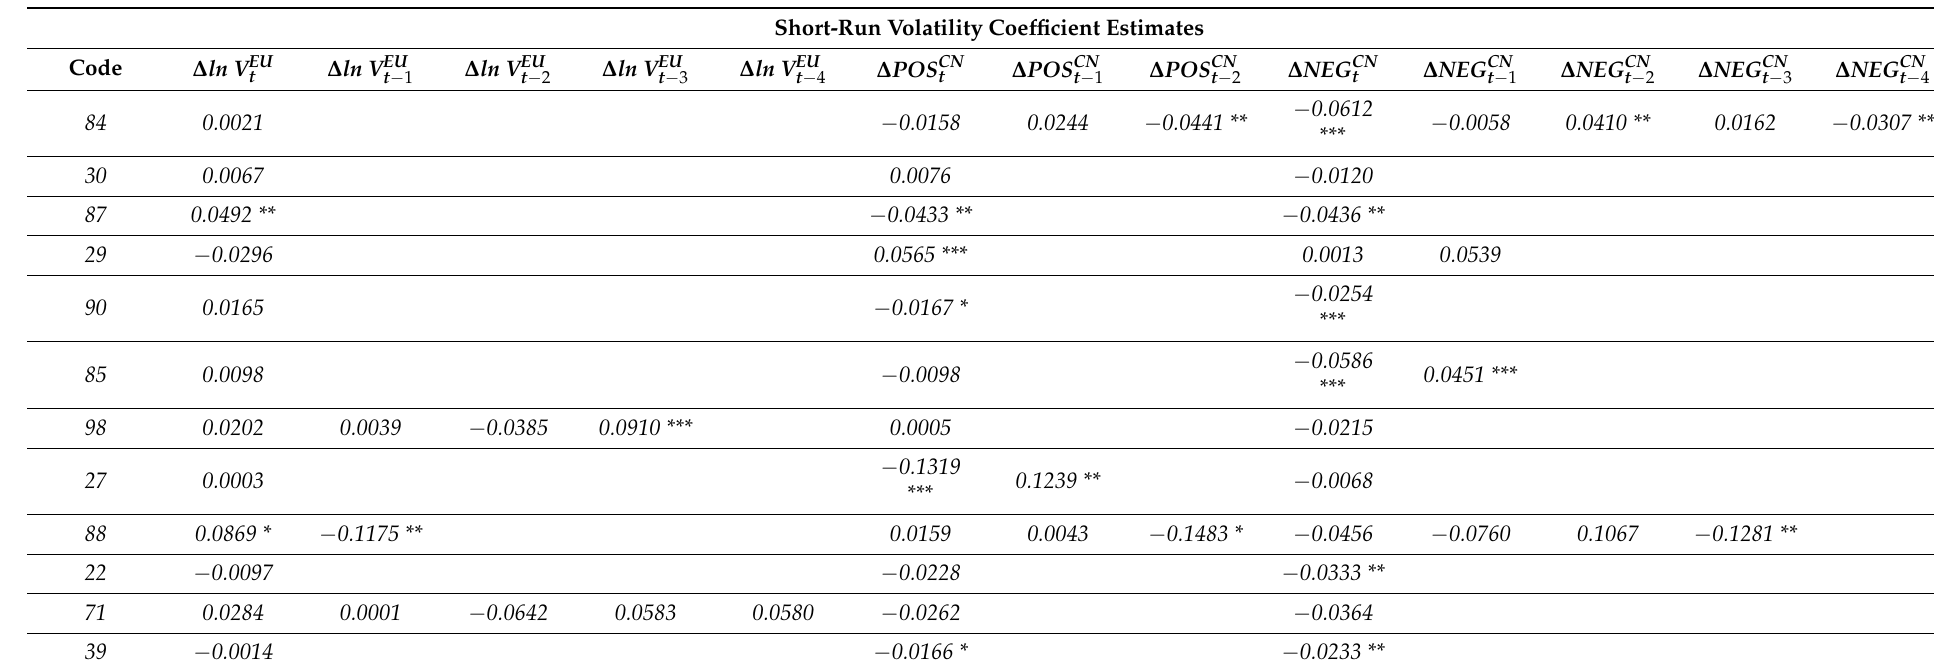
Table 10. Short-run coefficient estimates of volatility on the US imports from the EU with third country effects in the nonlinear ARDL model (9). Short-Run Volatility Coefficient